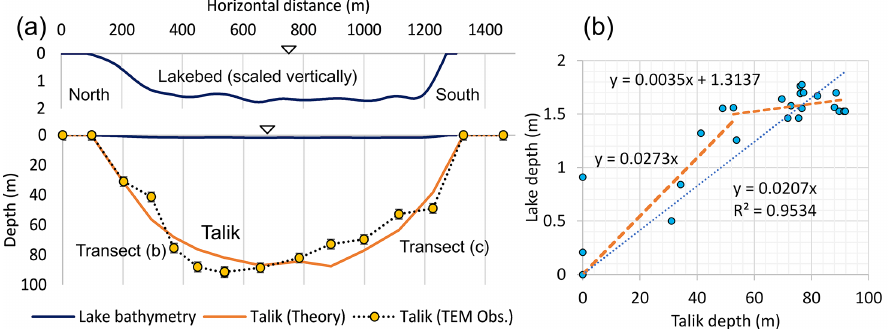
Figure 5. (a) Cross-sectional comparisons of the lake bed and the talik profiles along the two TEM transects (b) through (c) (Lenz et al., 2016) in Peatball Lake. Panel (b) displays the cross plot of the observed talik and lake depths at all 27 TEM data